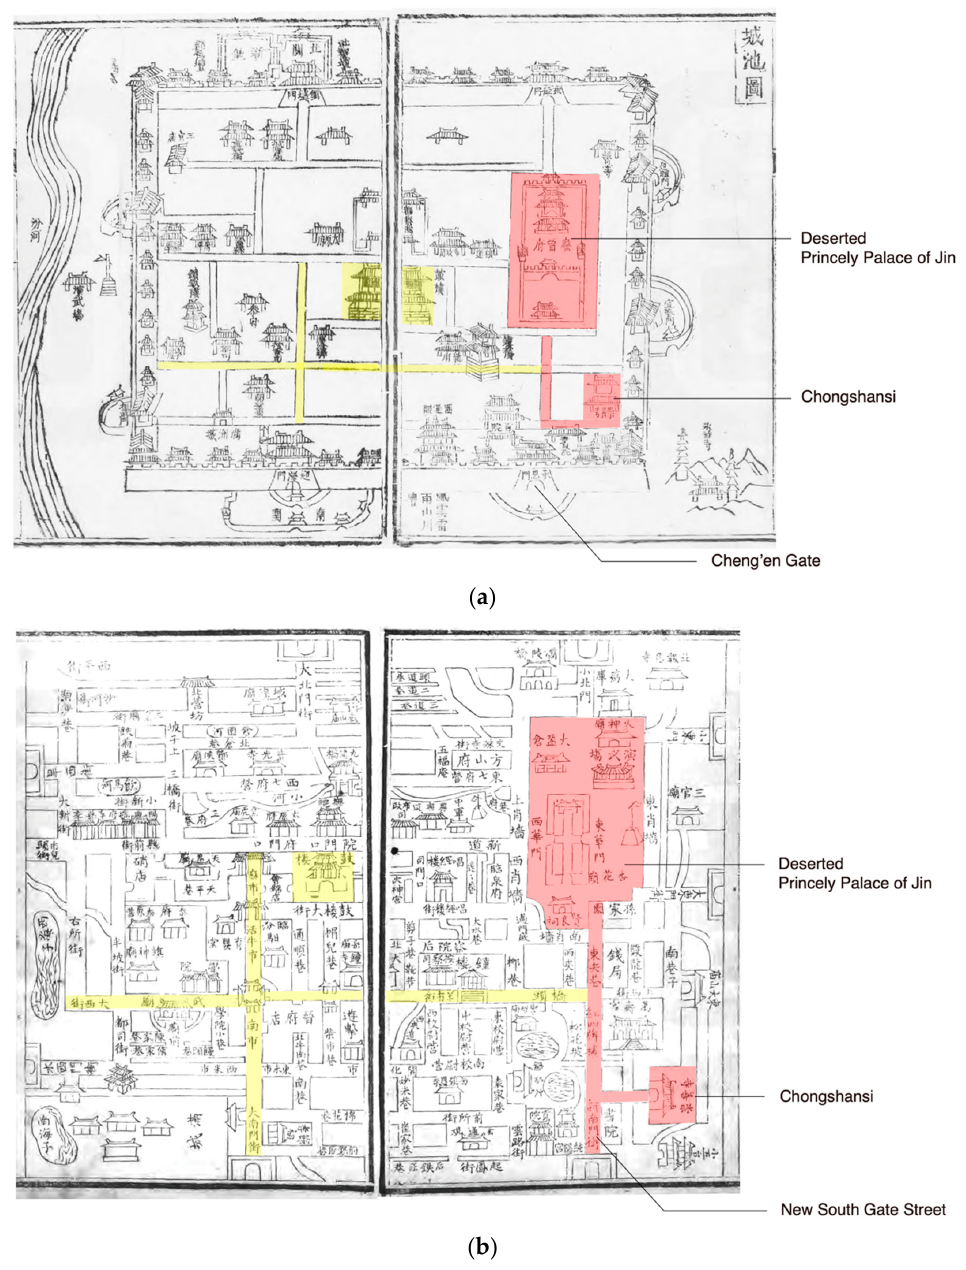
Figure 7. Chongshansi in city maps published during the Qing Dynasty: ( a ) Chengchi tu 城池圖 in Kangxi Yangqu xianzhi (1682); ( b ) Jiexiang tu 街巷圖 in Daoguang Yangqu xianzhi (1843).